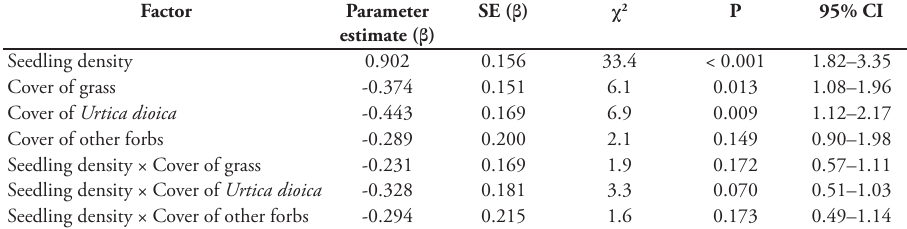
Table 2. Results from Cox’s proportional hazards analysis of factors influencing the survival of wild cu- cumber seedlings and young plants (n = 421).